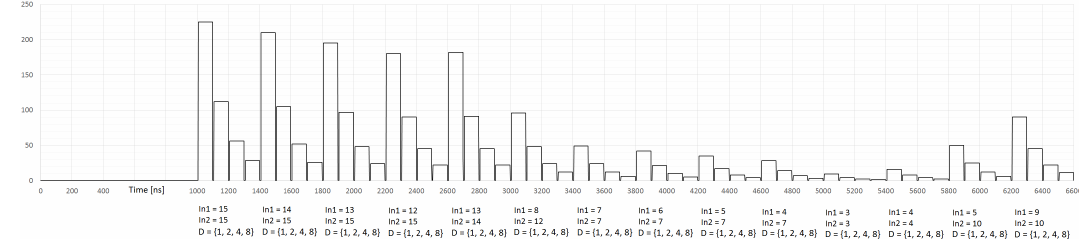
Figure 17. Output signal from the TNF block and the overall chip recalculated to decimal